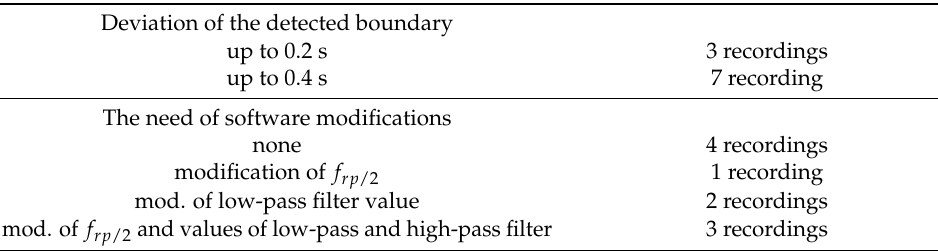
Table 3. Success of detection of boundaries of respiratory phases–recordings with significant noise.